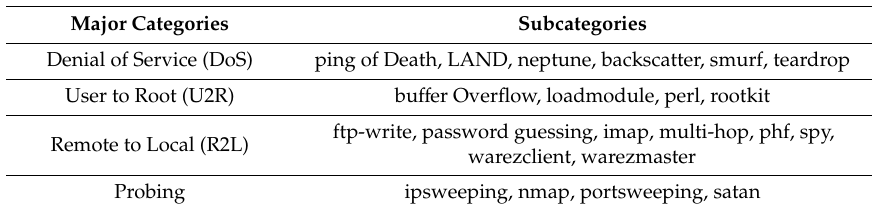
Table 1. Categories of attacks [30].